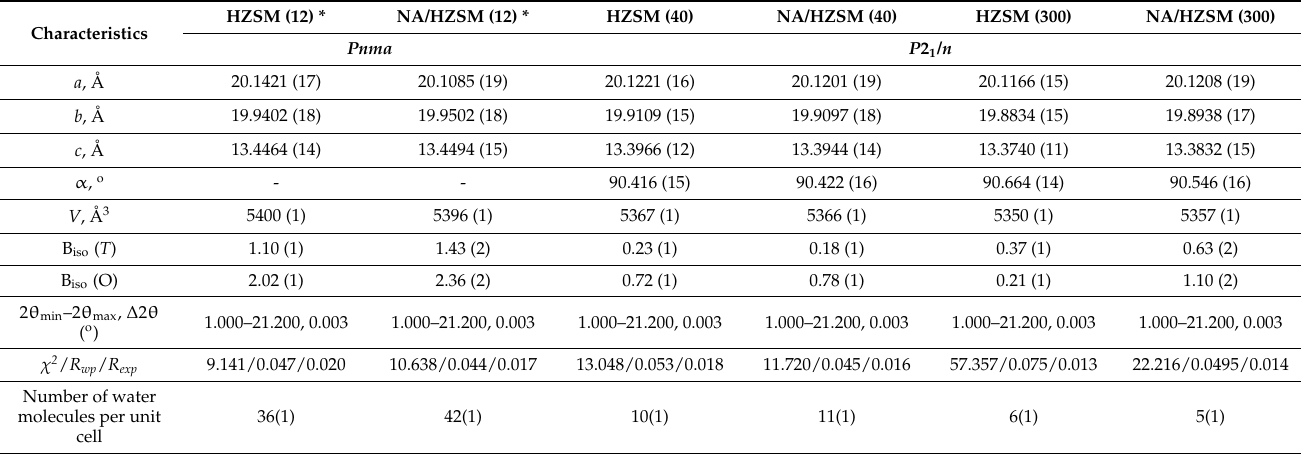
Table 3. Crystallographic parameters of HZSM (12, 40, 300) and NA/HZSM (12, 40, 300).